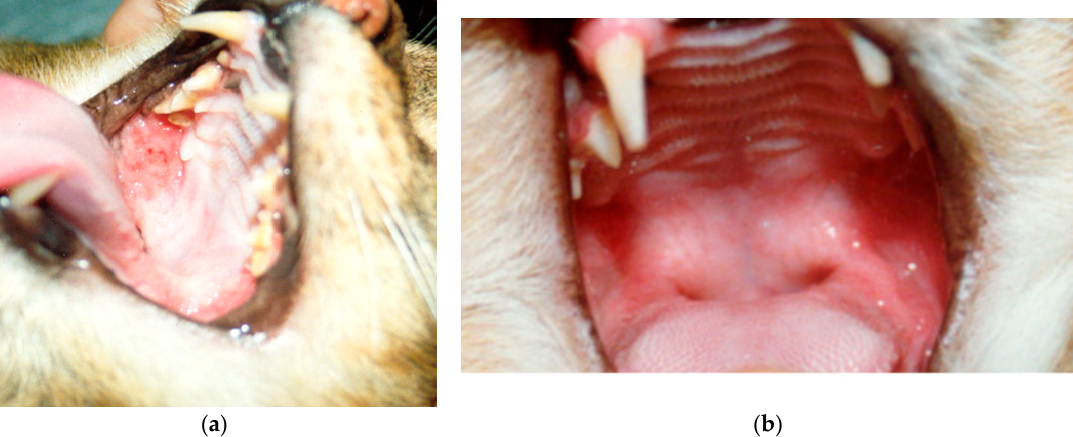
Figure 1. Effect of IFN α treatment in cats affected by FIV. ( a ) Opportunistic lesions in the oral cavity of a cat affected by FIV, before IFN oral treatment; ( b ) resolution of the oral cavity lesions after IFN oral treatment in the same cat [16].